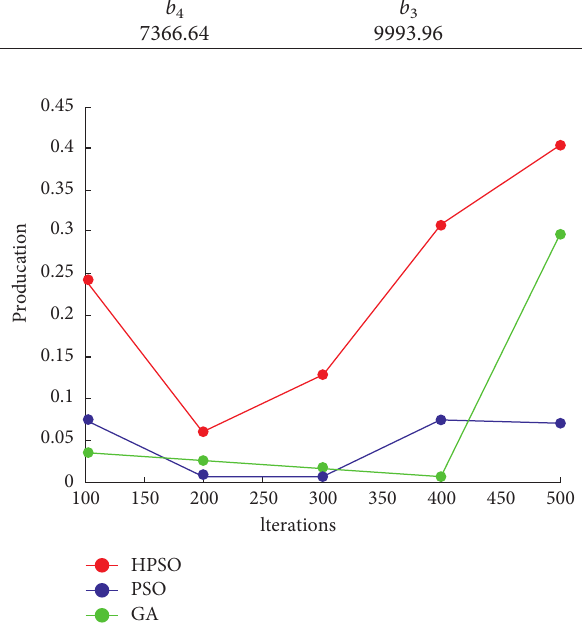
Figure 5: Production function of the proposed HPSO with existing PSO and GA based on production function. Table 2: Comparison of the production function of the proposed HPSO with existing PSO and GA based on production function.